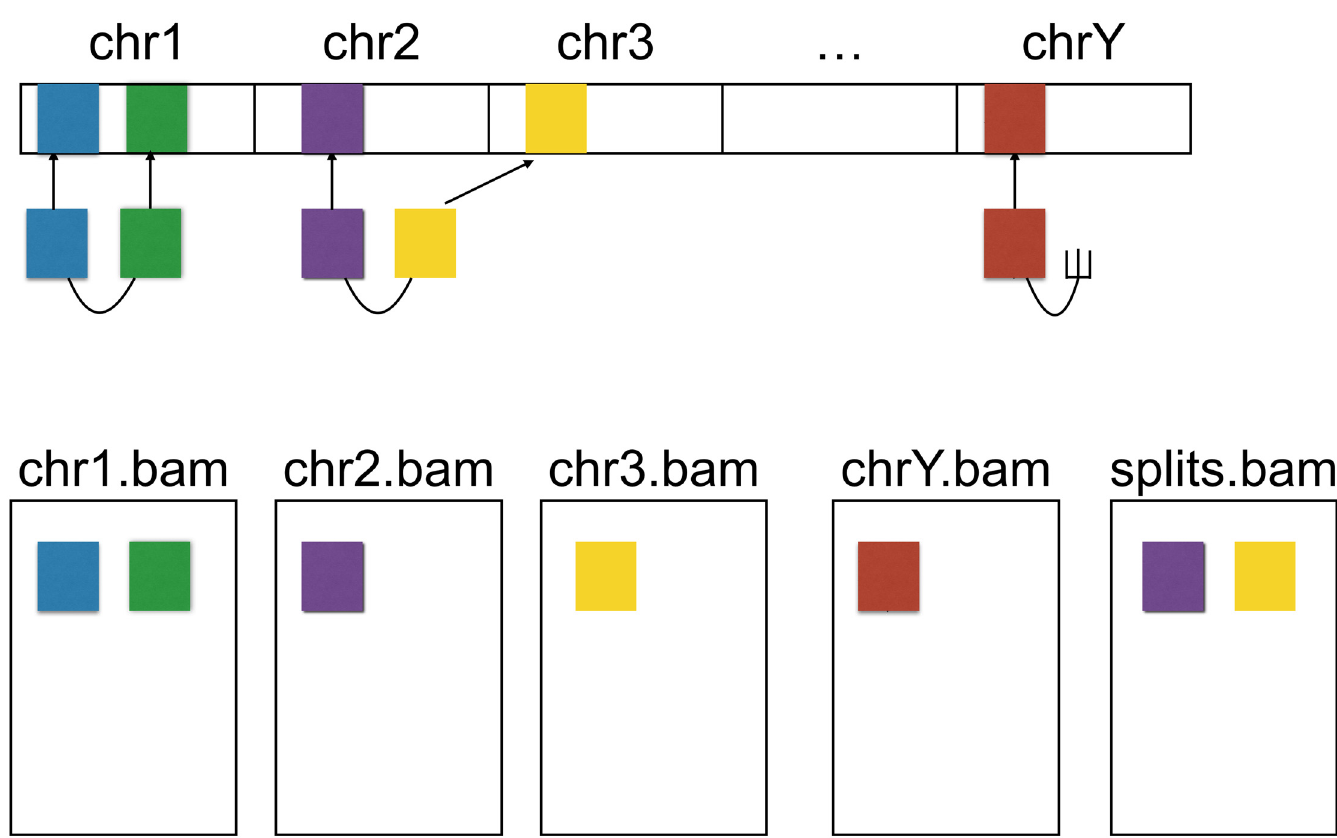
Fig 3. Distribution of read pairs and fragments among split files. elPrep allows splitting SAM files into smaller files which can be processed in parallel, without information loss. The figure shows the mapping of the reads to the reference (top) and shows that elPrep generates a file per genomic region (bottom). Pairs (see chr1) and fragments (see chrY) that map to a single genomic region are put in the files that match those regions. Pairs where reads map to different genomic regions (see reads mapping to chr2 and chr3) are put in a separate split file (far right). The individual reads of those pairs are also duplicated in the files that match the genomic regions where the reads map. This strategy guarantees that all split files contain all information for duplicate marking.